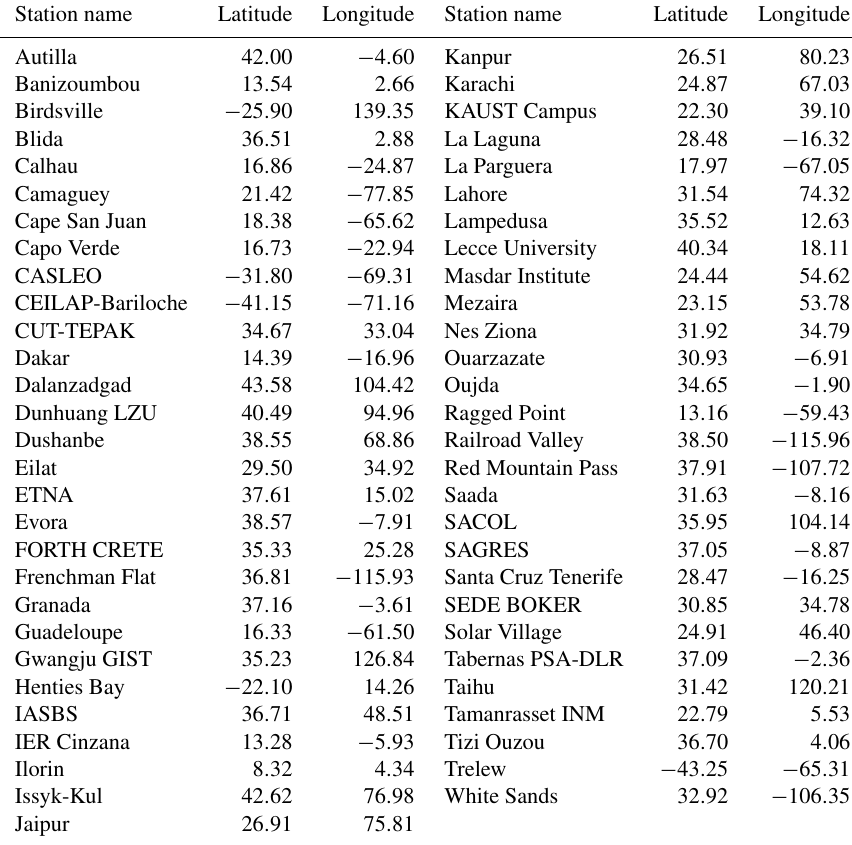
Table C1. List of AERONET stations used for comparison with MONARCH results. Station